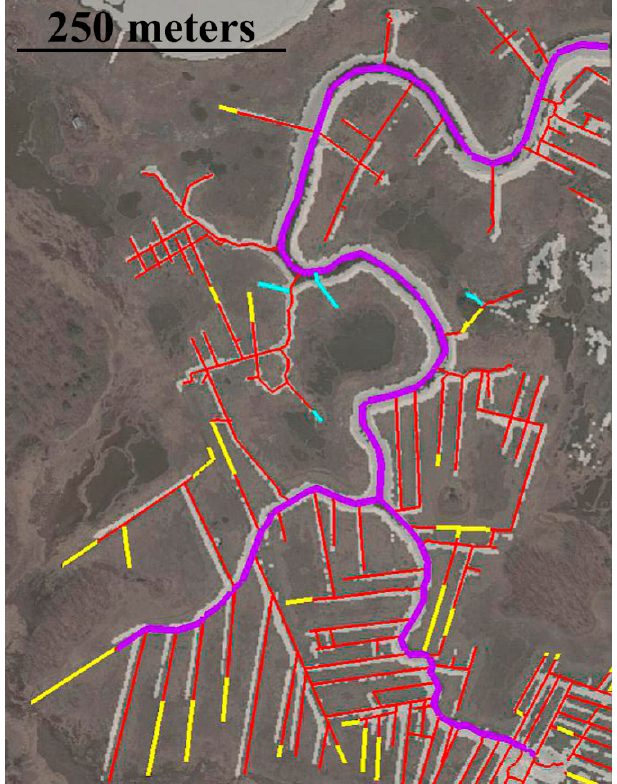
Figure 6. Map of creeks (purple) and ditches (red) derived from aerial imagery by the union of two operators’ assessments of aerial images from September 2014, June 2015, May 2016, April 2017 and April 2018, and present in the airborne lidar classification of creeks and ditches (gray). Sections not represented in the airborne lidar classification are shown in yellow, and sections which were present in two or fewer of the aerial images assessed are shown in blue. Aerial imagery source: Google.